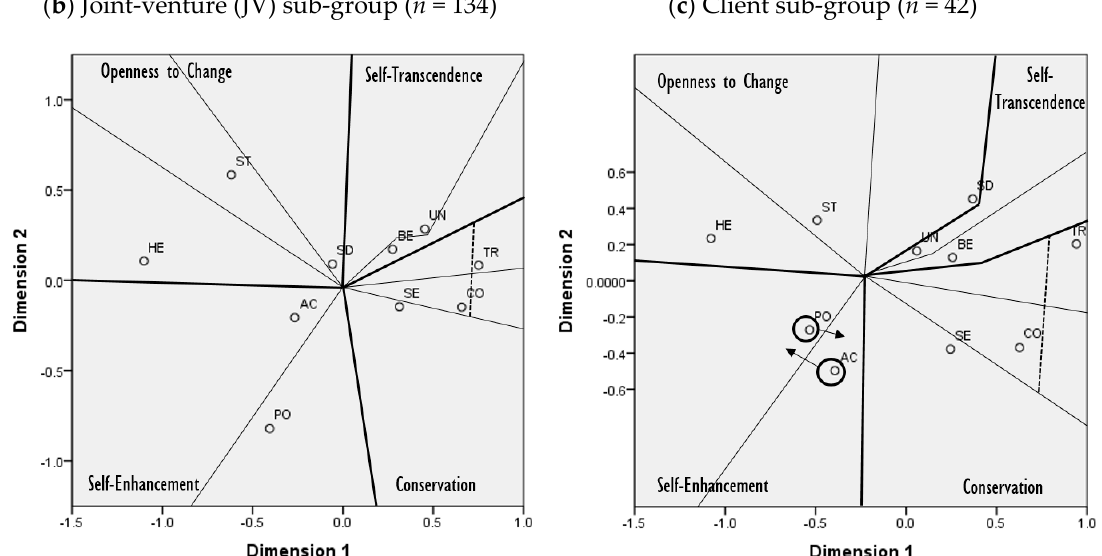
Figure 2. ( a – c ) Two-dimensional multidimensional scaling (MDS) of the overall project values data, including the sub-groups. Key to value categories: UN = Universalism, BE = Benevolence, TR = Tradition, CO = Conformity, SE = Security, PO = Power, AC = Achievement, HE = Hedonism, ST = Stimulation, SD = Self-Direction.